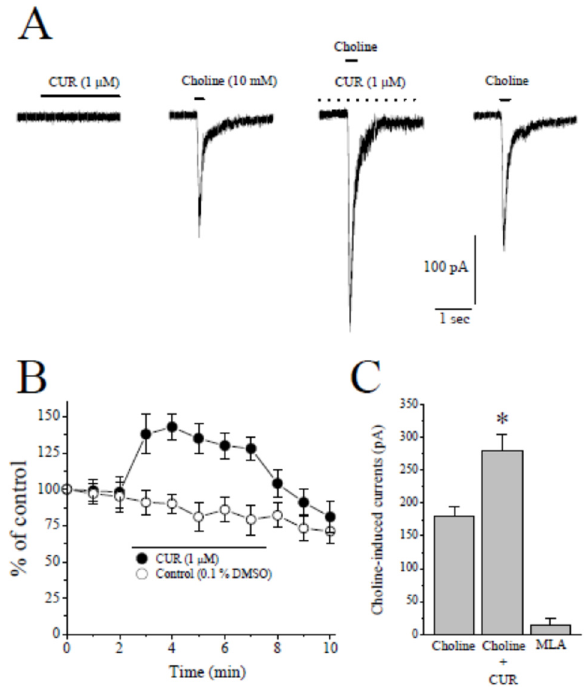
Figure 2. The effect of curcumin on choline-induced ion currents recorded in CA1 area stratum radiatum interneurons of rat hippocampal slices. ( A ) Recordings of holding current in the presence of curcumin for 30 s (on the left), choline-induced currents before (control, second panel from left), during (5 min of curcumin) and after (2 min of recovery) the bath application of 1 µM curcumin in hippocampal interneurons. Choline application was represented with a short solid bar on top of the current traces. The dashed line indicates continuing bath application of curcumin. ( B ) Time-course of the effect of vehicle (0.1% DMSO; open circles) and curcumin (1 µM; filled circles) on the peaks of the Choline-induced currents. Each data point represents the normalized mean ± S.E.M. of five to seven experiments. The duration of drug application is indicated by the horizontal bar in the figure. ( C ) Summary of the effects of curcumin and methyllycaconitine on the peak amplitudes of choline induced currents. Bars represent the means ± S.E. of four to eight experiments (* p < 0.05 vs. control; ANOVA). MLA, methyllycaconitine.